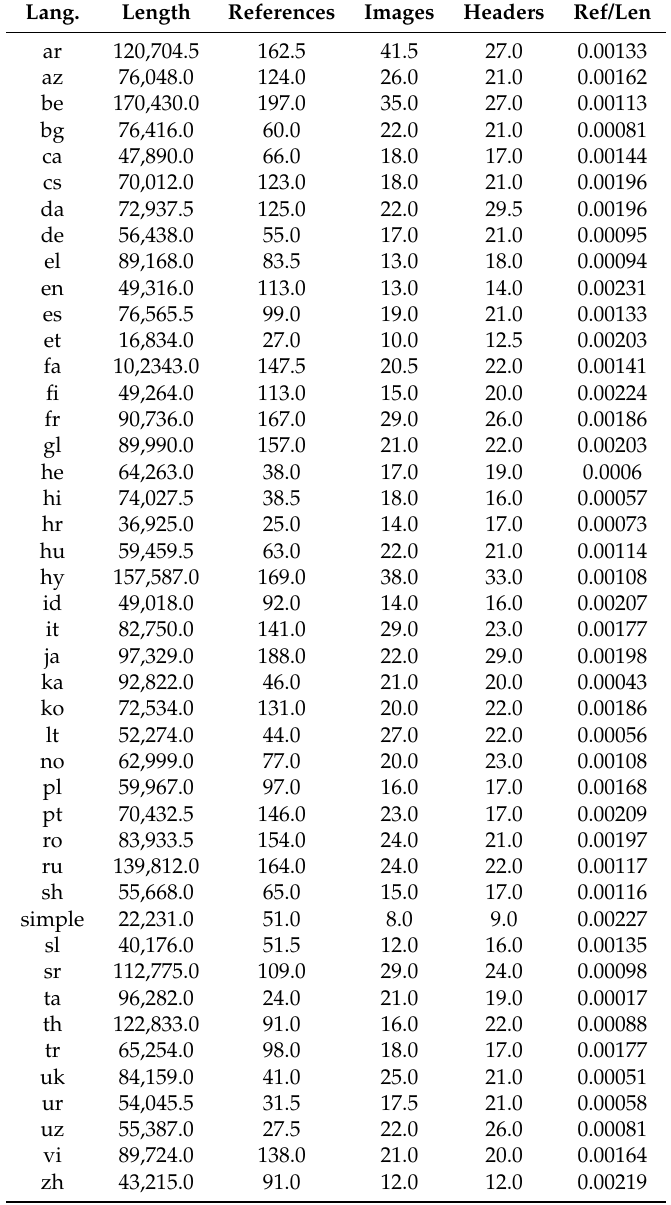
Table 3. Median metrics values in the highest quality class in various Wikipedia languages. Source: own calculation.